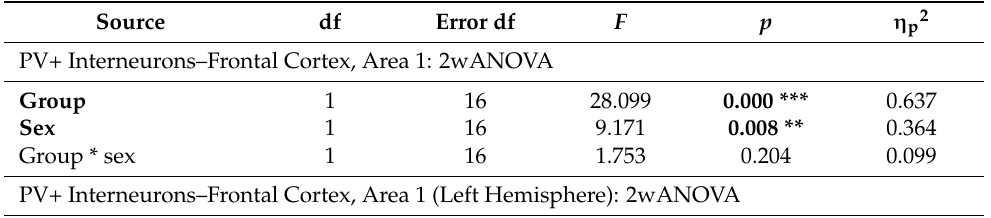
Table A3. Two-way ANOVA table for the number of parvalbumin-positive (PV+) interneurons in various brain areas and the number of microglia in the dentate gyrus (DG) of the dorsal hippocampus.